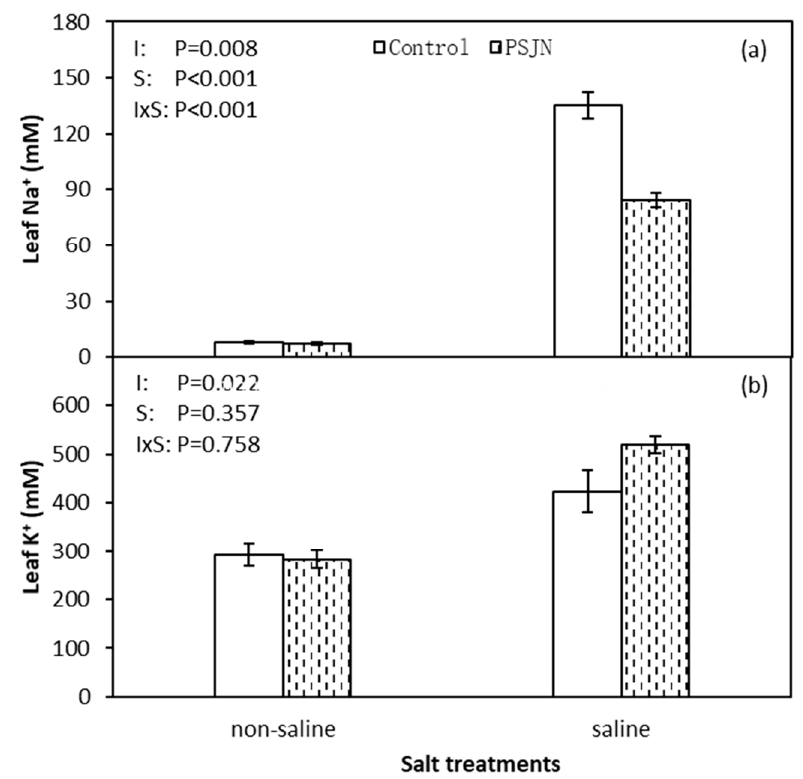
Figure 3. Leaf Na + ( a ) and K + ( b ) concentration of quinoa leaves a ff ected by bacterial inoculation in non-saline (0 mM NaCl) and saline (400 mM NaCl) irrigations. PsJN indicates Burkholderia phytofirmans PsJN. I and S indicate inoculation and salinity treatments, respectively, and I × S indicates the interaction. Error bars indicate S.E. ( n = 4).